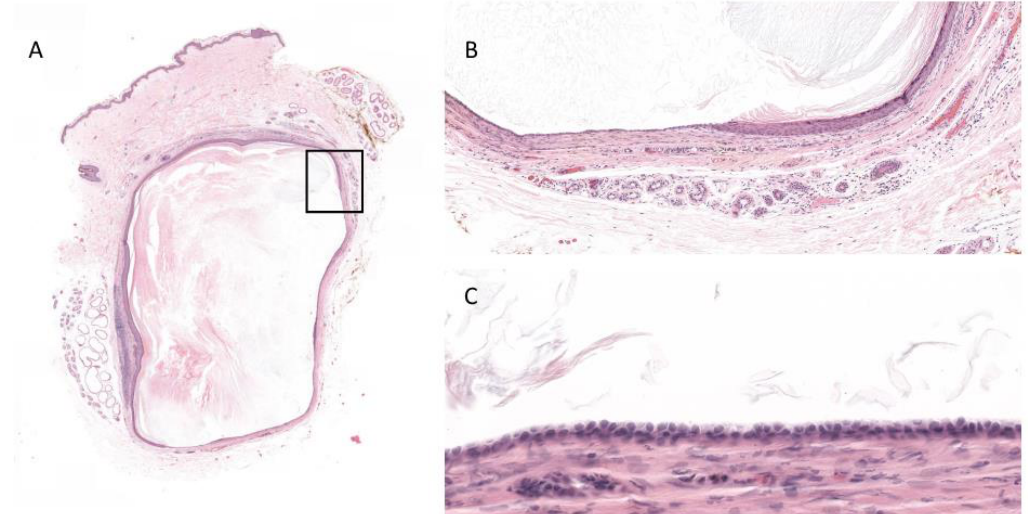
Figure 1. Histology. ( A ) HE ×10. The whole cyst. ( B ) HE Magnification ×20 (inset). Transition between epidermoid and apocrine epithelium. ( C ). HE ×40 Magnification. The apocrine epithelium.